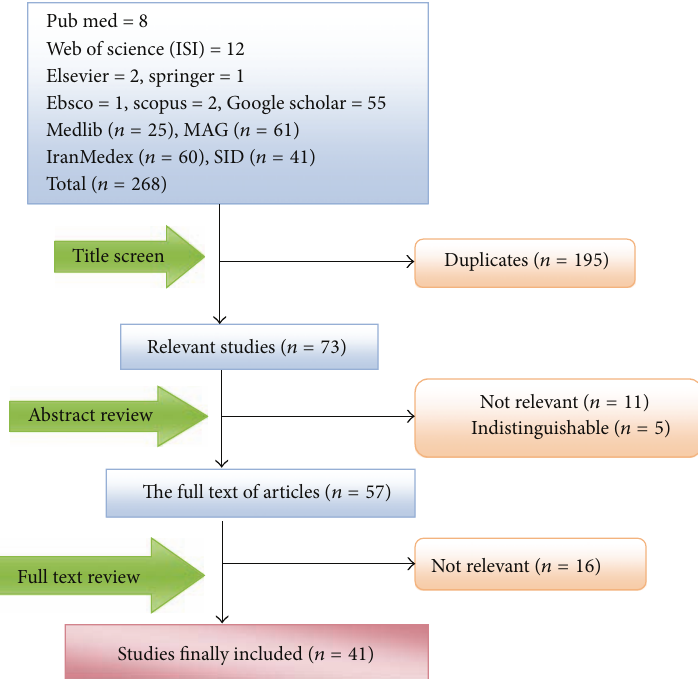
Figure 1: Results of the systematic literature